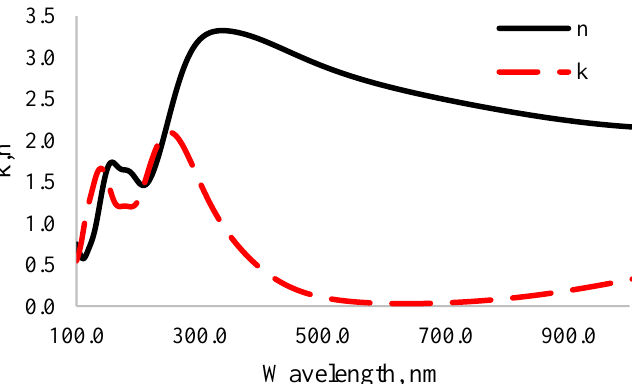
Figure 7. Dependence of the complex refractive index of MoO 3 on light wavelength.